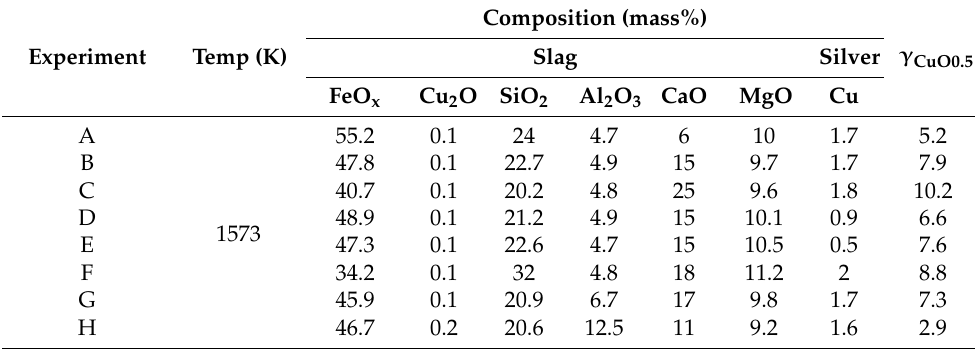
Composition (mass%)